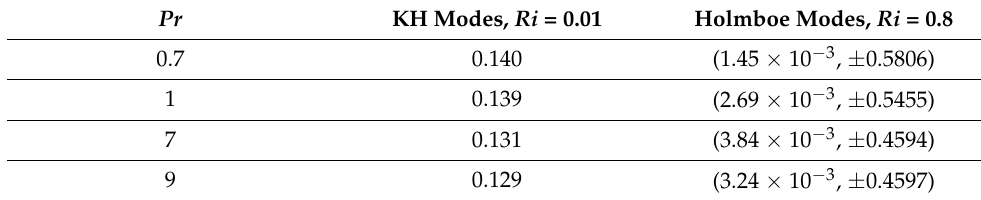
Table 2. Least unstable eigenvalues at various Prandtl numbers for α = 0.5, β = 0, Re = 1000. Pr KH Modes, Ri = 0.01 Holmboe Modes, Ri =